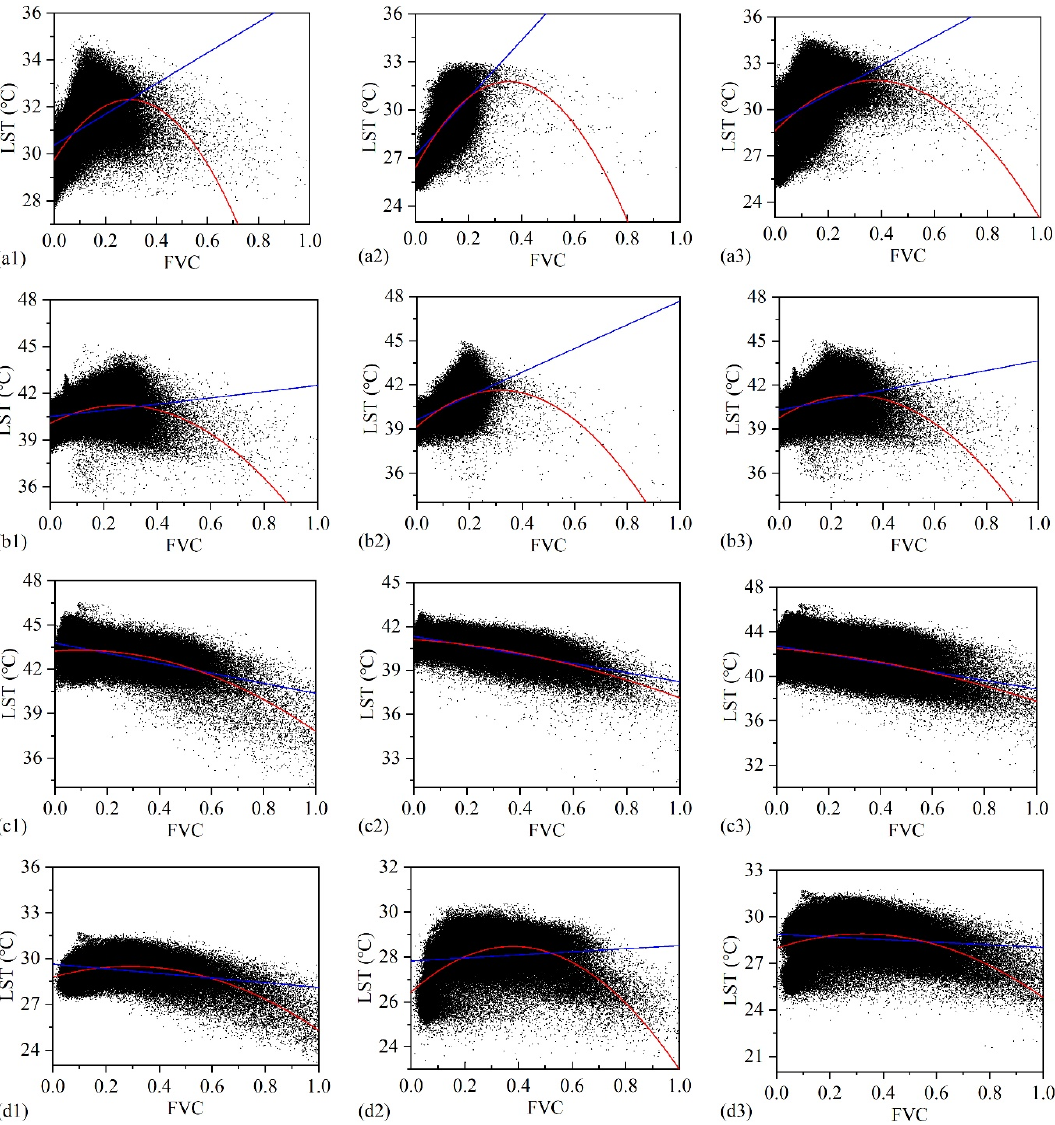
Figure 2. Relationship between FVC and LST at grid scale on P1–P4 (( a ), P1; ( b ), P2; ( c ), P3; ( d ), P4. ( 1 ), S1–S6; ( 2 ), S7–S12; ( 3 ), S1–S12. The blue line is linear fitting line, and the red line is binomial fitting line between FVC and LST.).